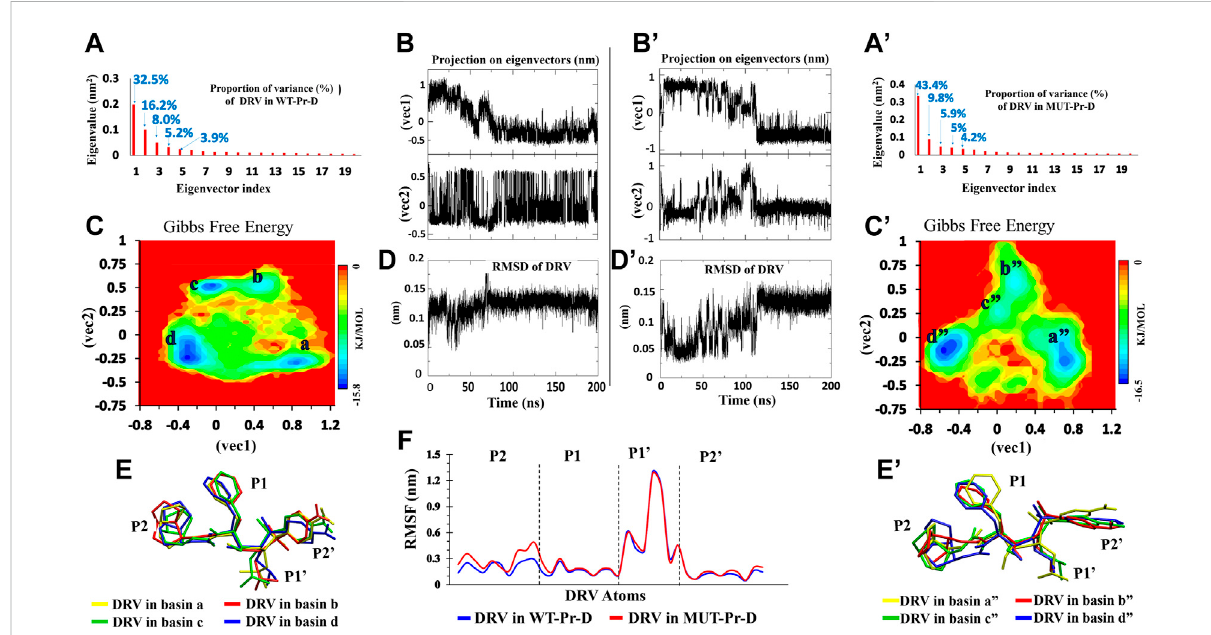
FIGURE 3 PCA for DRV in complex with WT-Pr-D (left) and MUT-Pr-D (right). (A,A ’ ) The Eigenvalue for the fi rst 20 eigenvectors and proportion of the variance with respect to corresponding eigenvectors; (B,B ’ ) The projection of trajectory on the two fi rst eigenvectors (PCs); (C,C ’ ) The free energy landscape obtained from fi rst two eigenvectors; (D,D ’ ) The RMSD of DRV; (E,E ’ ) The snapshot of lowest energy conformation of DRV in each basins; (F) The RMSF of non-hydrogen atoms of DVR ’ s